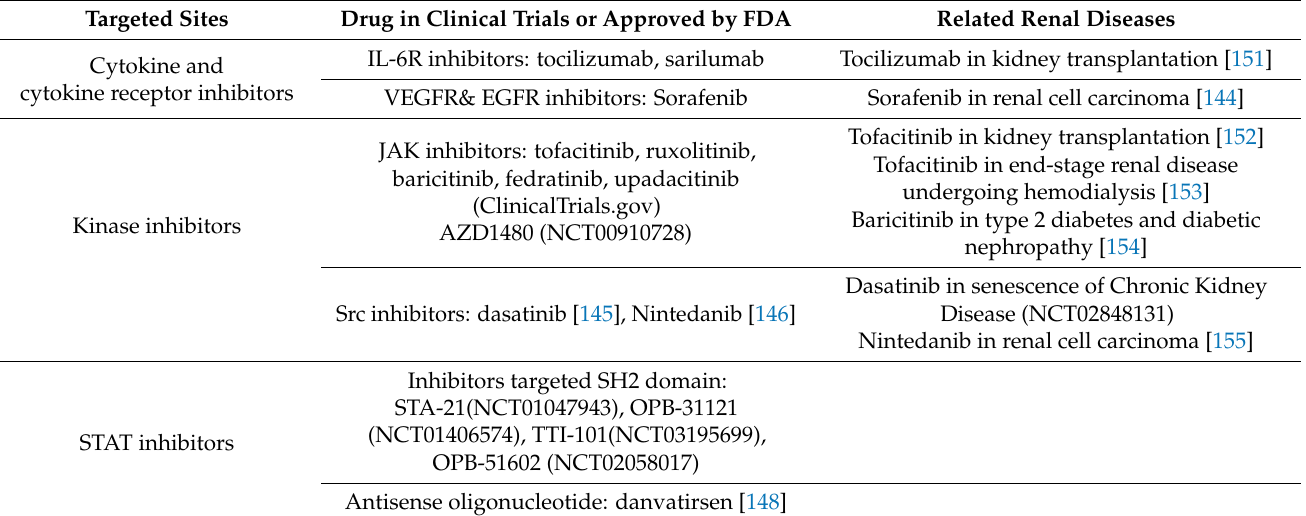
Table 3. Pharmacological Inhibition of STATs in renal